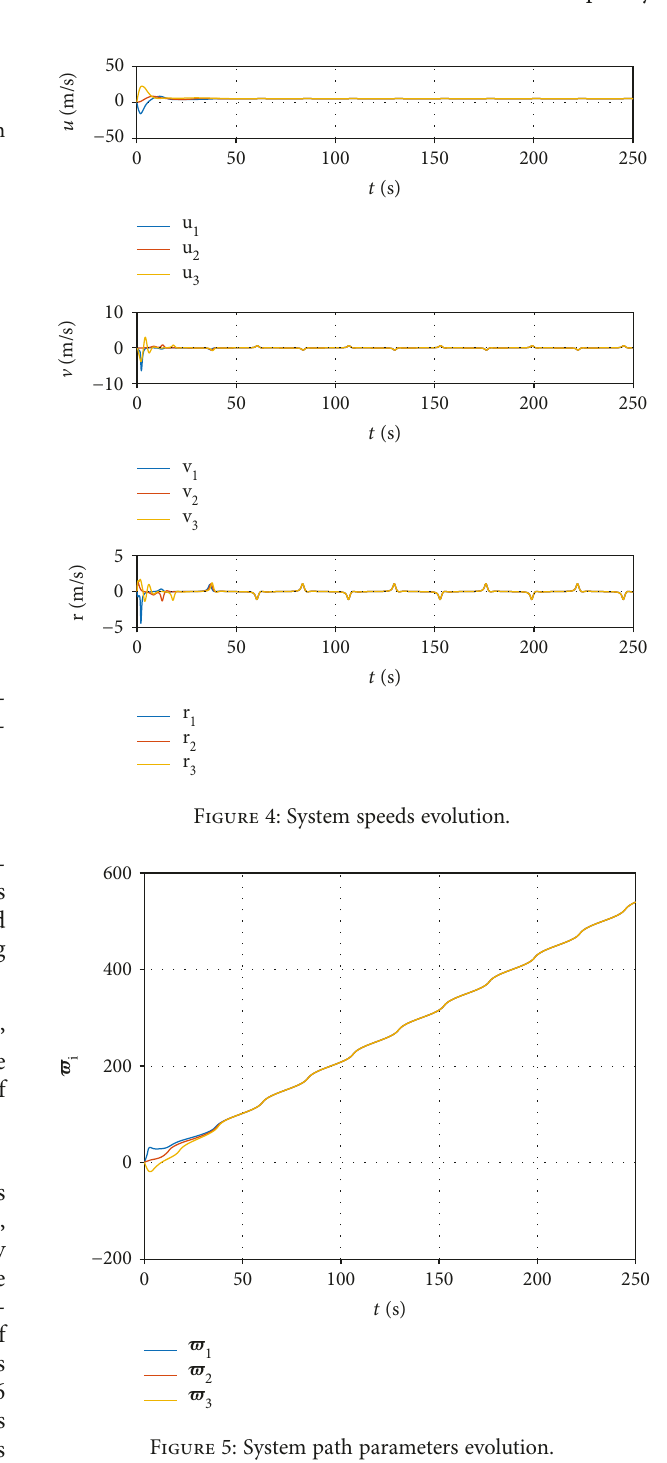
Figure 5: System path parameters